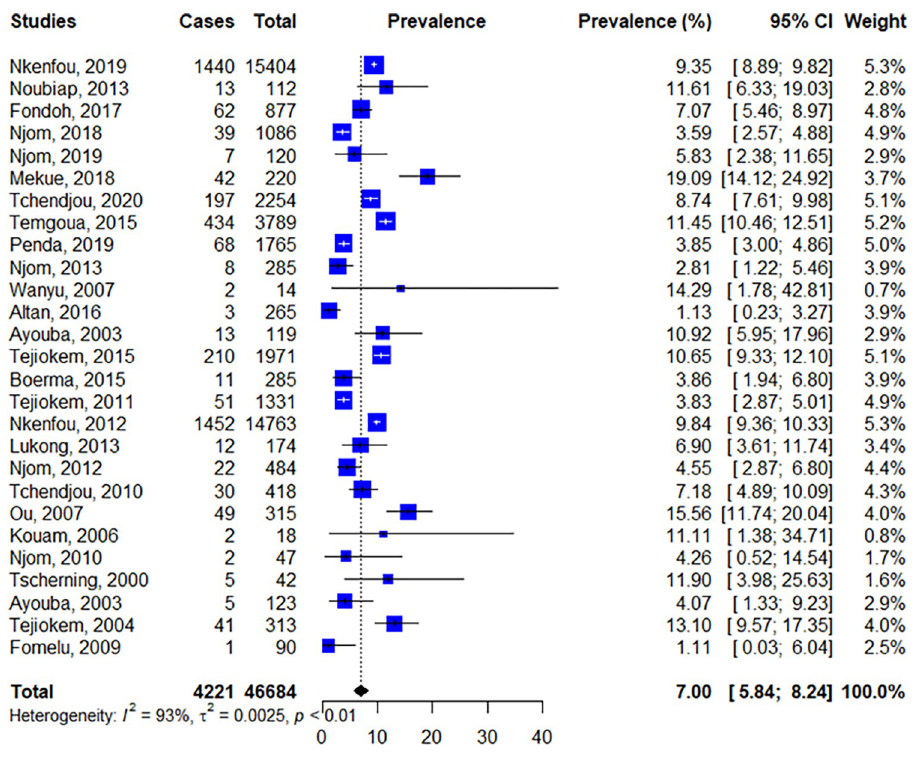
Fig 3. Forest plot of the prevalence of